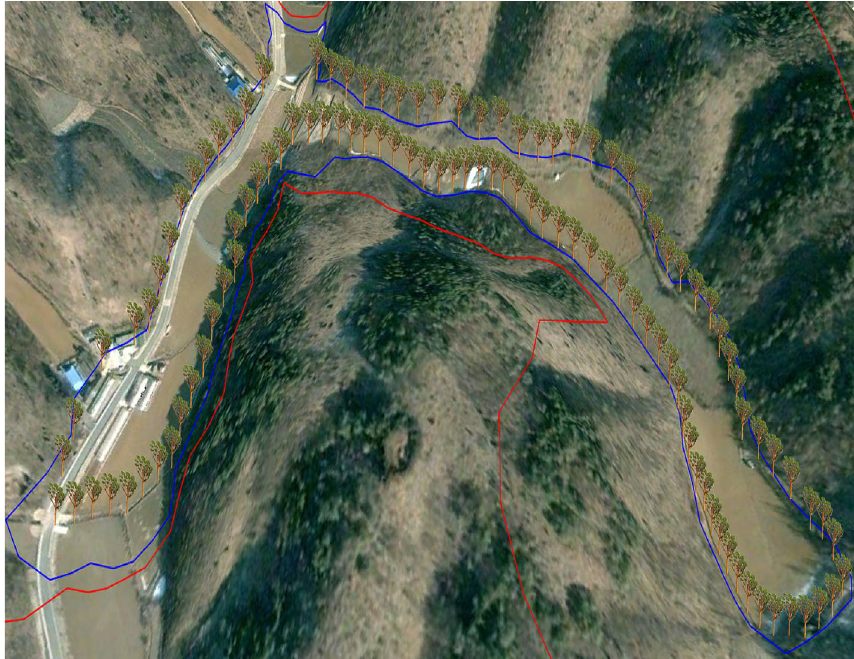
Figure 4. Solar tree installed around the space used as farmland (total: 114); see Fig. 2 for the location of the image. The satellite imagery was obtained from Google Earth Pro 7.3.4 (https:// www. google. com/ earth/ versi ons/# earth- pro). The map created in Google Earth Pro 7.3.4 and Adobe Photoshop CS3 (https:// adobe- photo shop- cs3- update. en. softo nic. com/).